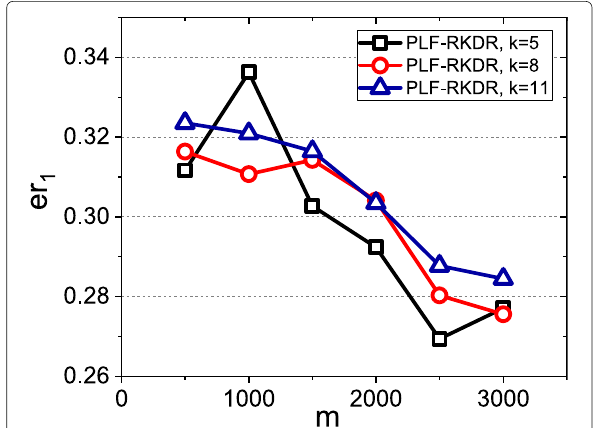
Fig. 3 The impact of m on the absolute error of PLF-RKDR algorithm on the simulation